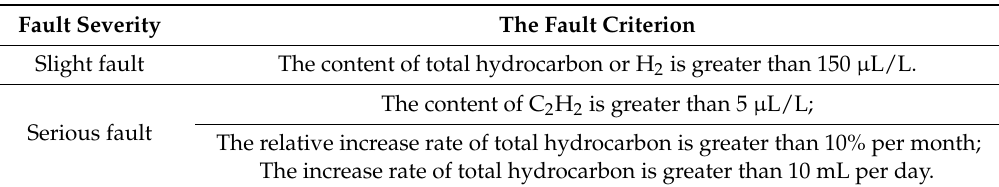
Table 7. The threshold values of the dissolved gas in oil.